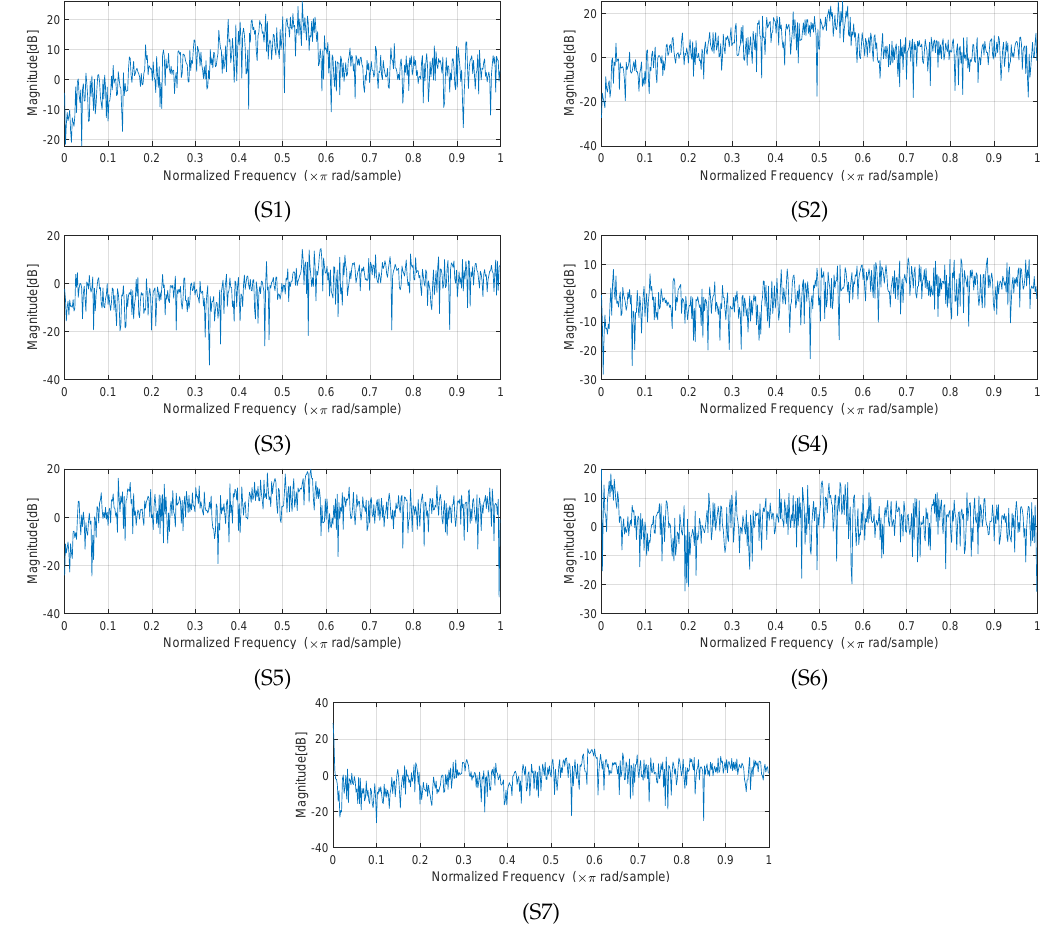
Figure 6. Magnitude frequency response of the 1024-th order FIR filters designed by the CNN for each one of the Alfa Romeo Giulia loudspeakers S1-S7 shown in Figure